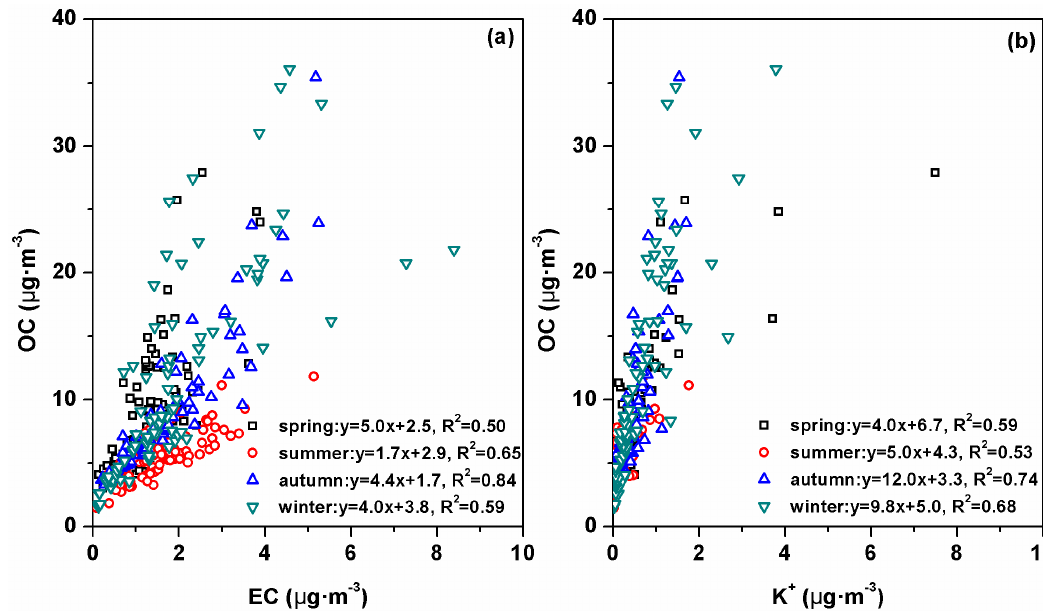
Figure 5. Scatter plots of OC (organic carbon) vs. EC (elemental carbon) ( a ) and OC and K + ( b ) in four seasons.